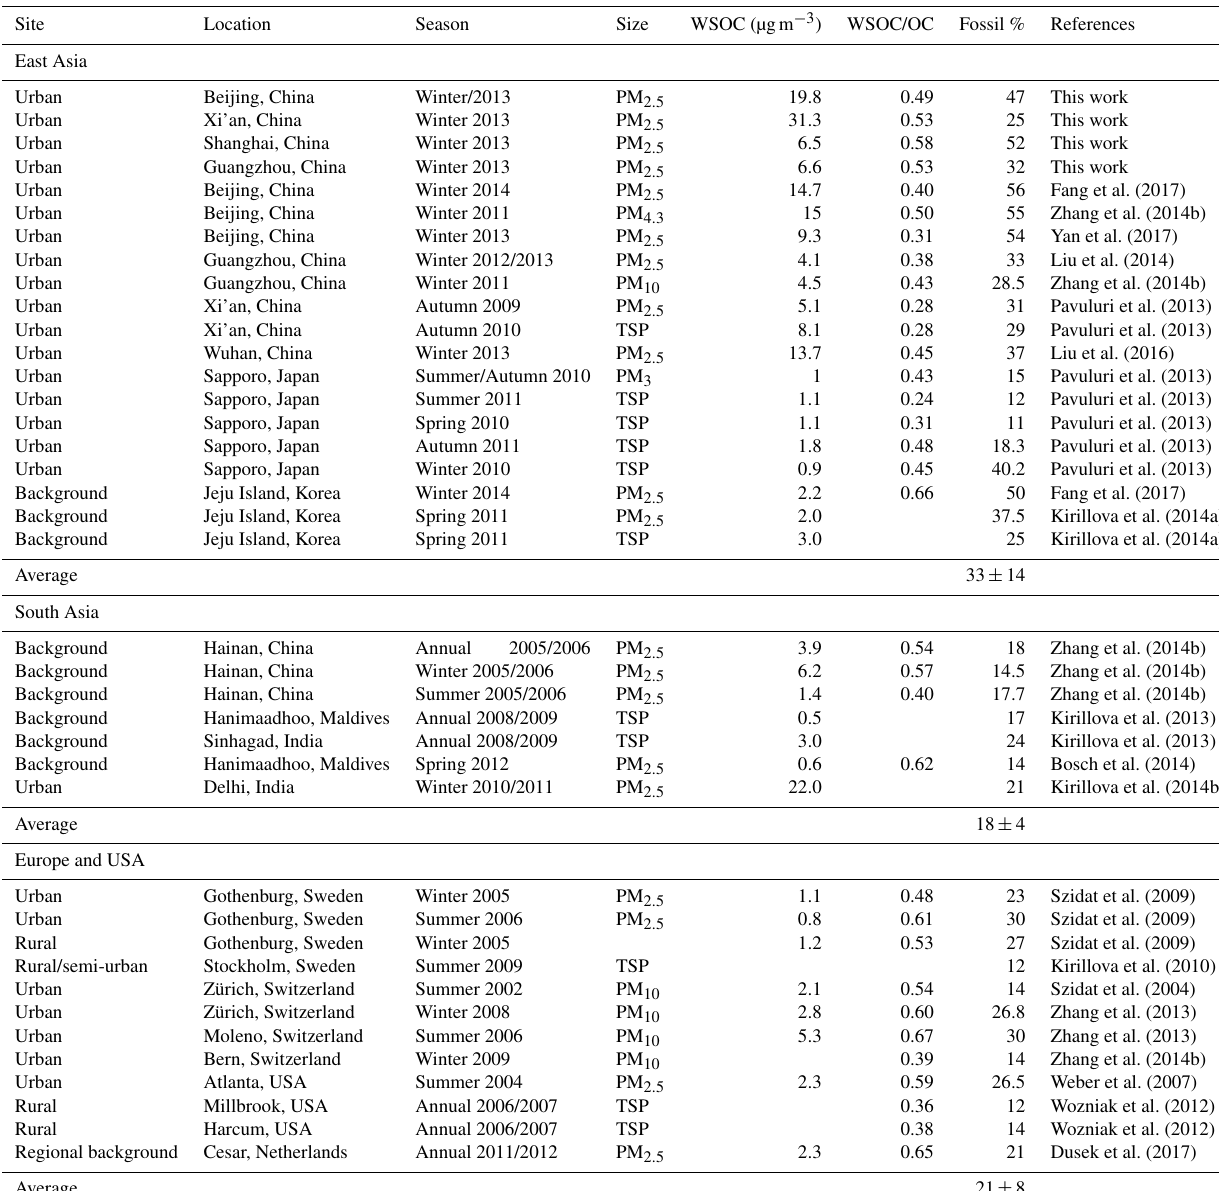
Table 1. Compilation of literature values of relative fossil fuel contributions (fossil %) to the WSOC aerosols in East/South Asia, USA and